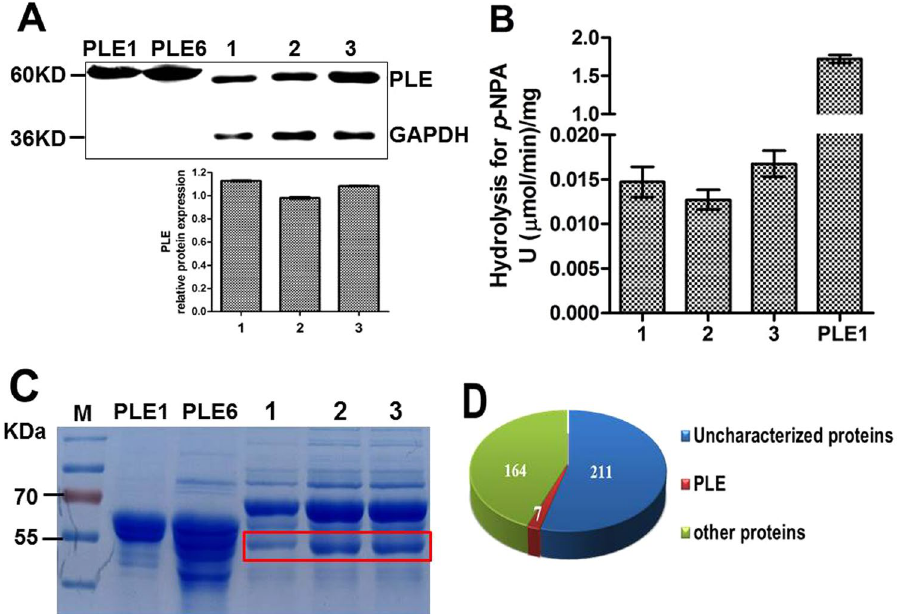
Figure 8. Detection the protein level of PLEs in pig serum and hydrolytic activity for p -NPA. ( A ) Western blotting of PLEs in serum pool samples. ( B ) Hydrolytic activity of pig serum for p -NPA. ( C ) SDS-PAGE detection of pig serum pool samples. Lane 1, 2 and 3 were serum pool samples (n = 4) from pigs in three different farms respectively and were diluted 100-fold with PBS (50 mM, pH 7.4), the recombinant PLE1 and PLE6 were used as positive controls. The gel piece in the red box was collected for shotgun proteomic analysis. ( D ) 382 kinds of proteins were detected by shotgun proteomic analysis, seven proteins belonged to the PLE family, 164 were known proteins, and 211 were unknown proteins in the UniProt database.